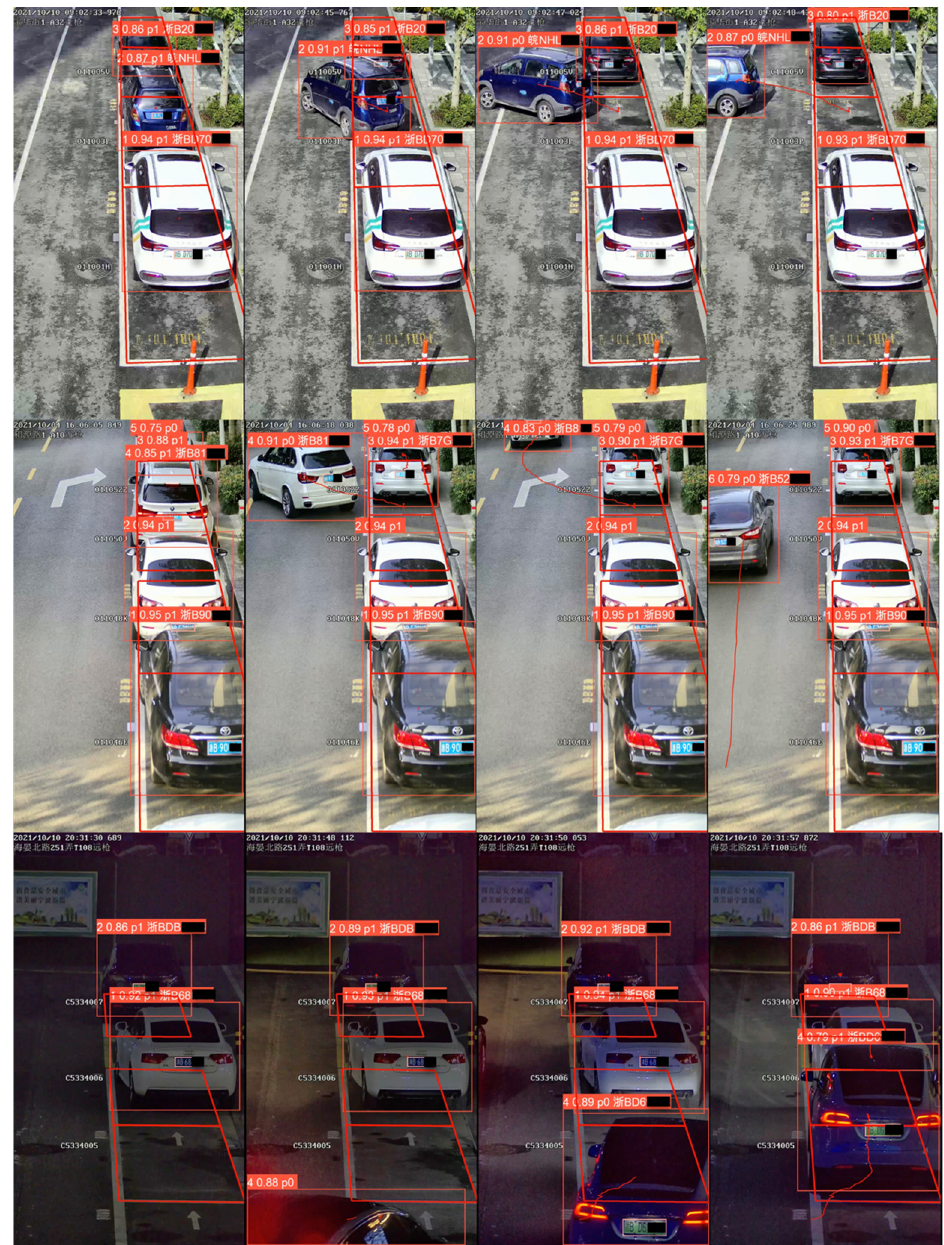
Figure 10. The qualitative results. (For privacy protection, license plate numbers are pixelated). Each bounding box is visualized as the label (Vehicle ID, Probability, Parking